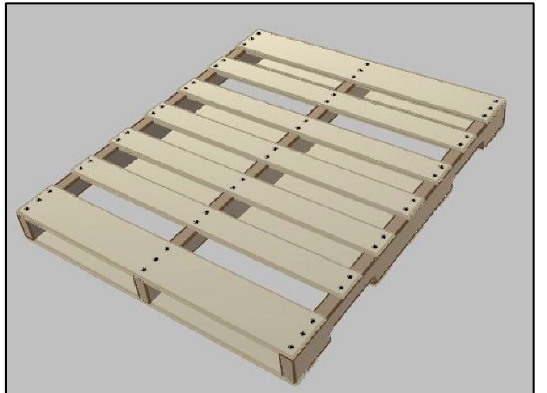
Figure 3. Picture of GMA pallet used for analysis (image generated using PDS™).